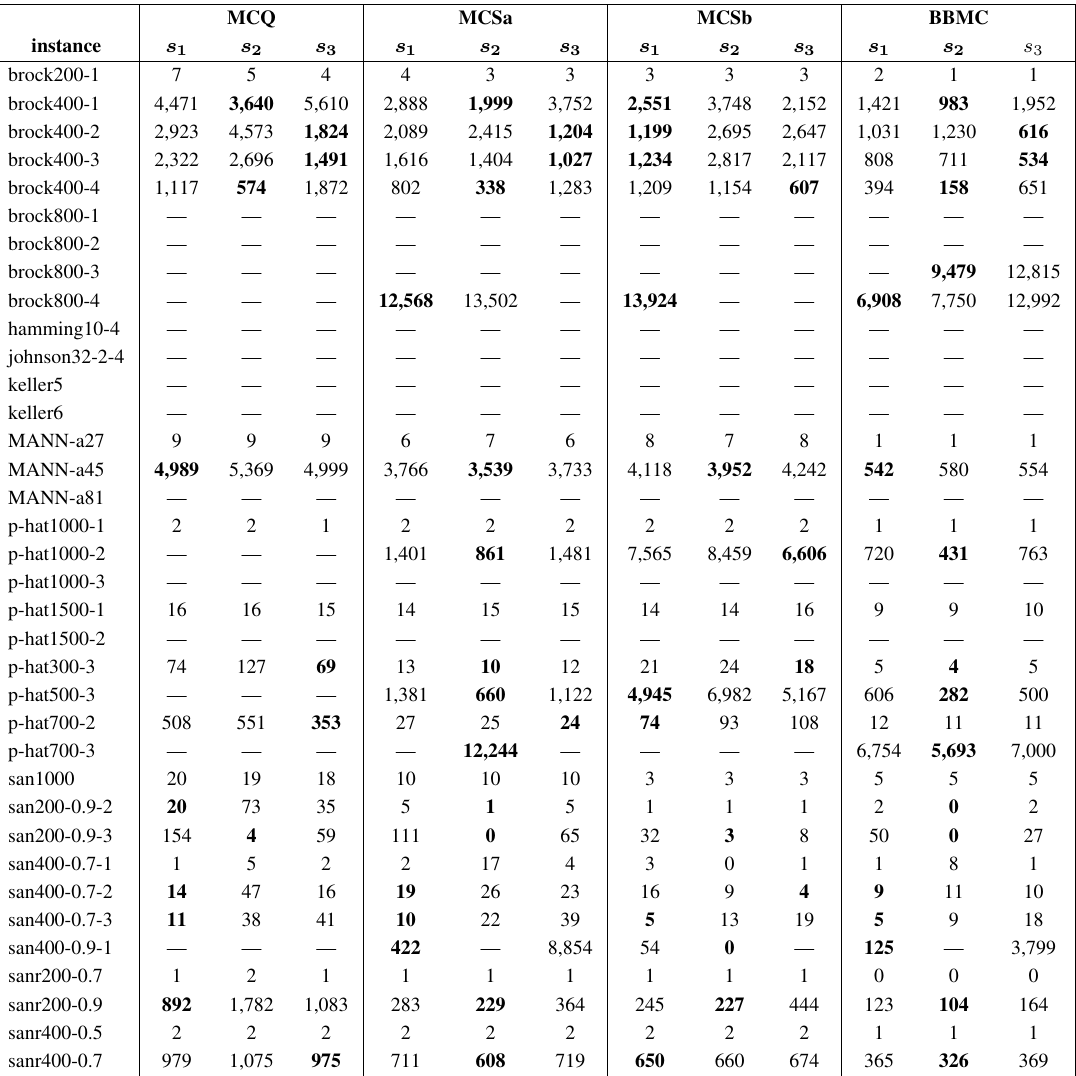
Table 3. DIMACS instances: The effect of style on run time in